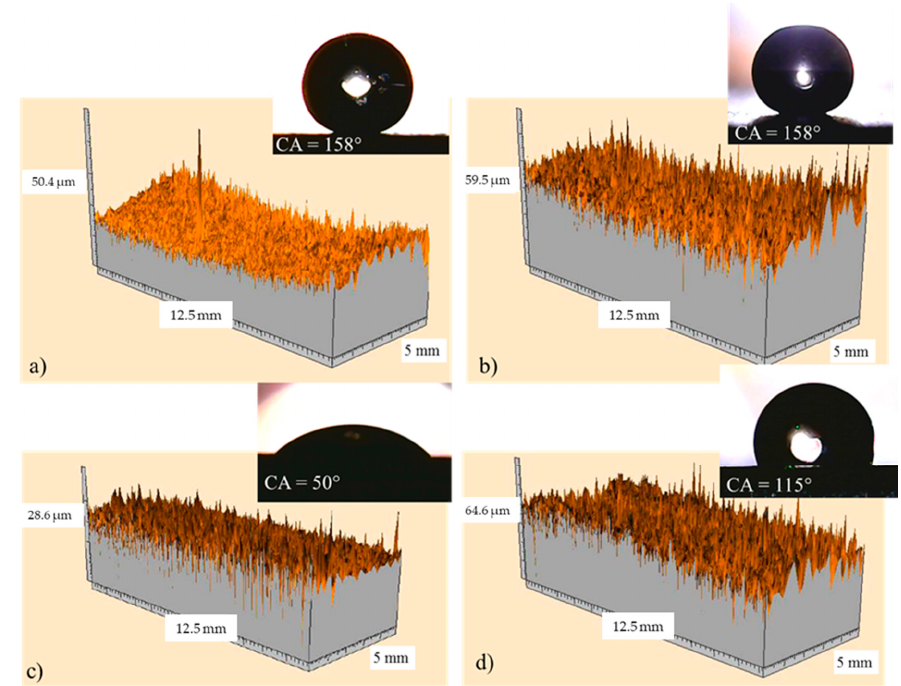
Figure 16 . Surface 3D profilometry obtained with the laser for coated sample 2 ( a ) and sample 7 ( b ); in ( c ) and ( d ) the corresponding references were also reported. In the insert, the pictures representative of the related water contact angles are shown.